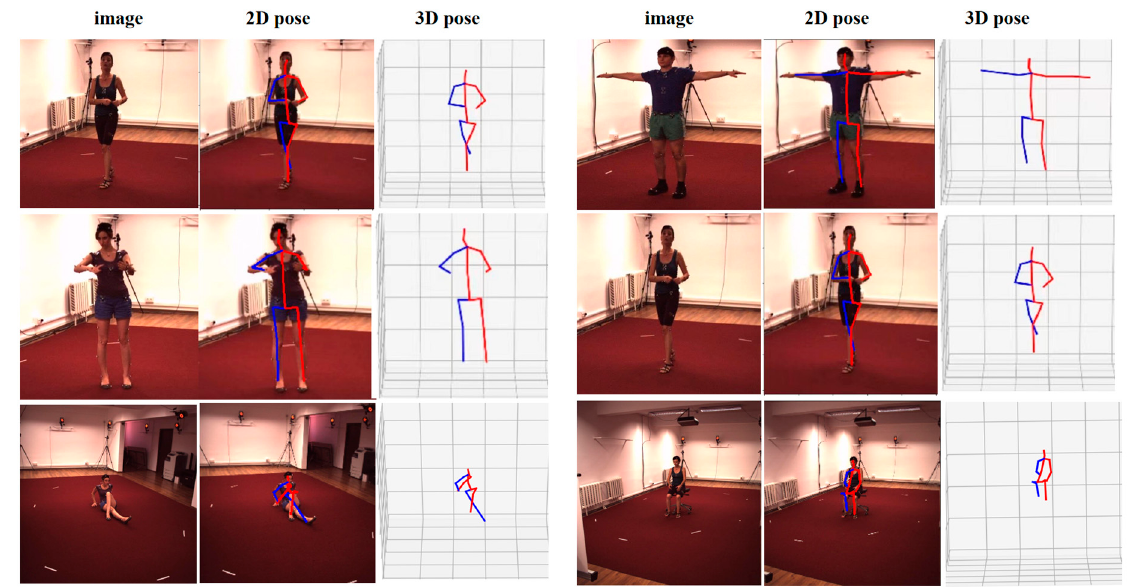
Figure 10. Examples of estimation results on the Human3.6M dataset (from left to right , the columns show the original image, 2D pose, and 3D pose).